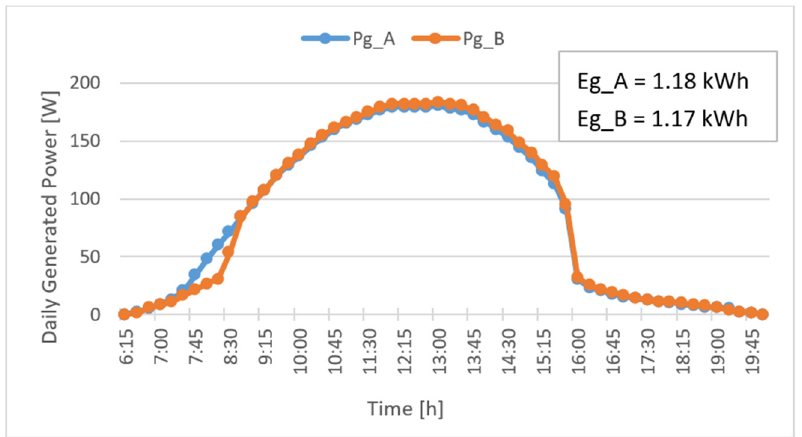
Figure 5. Daily power generation curves, Pg_A and Pg_B, of the two PV generators A and B, on a July 2021 cloudless day, together with corresponding daily generated energy values, Eg_A and Eg_B.